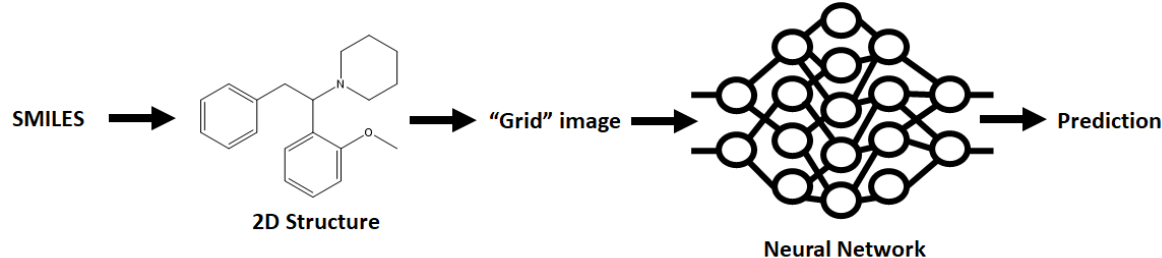
Figure 4. The concept behind the ChemCeption methodology of generating a neural network that relates the 2D structure of a molecule to a trained chemical property.